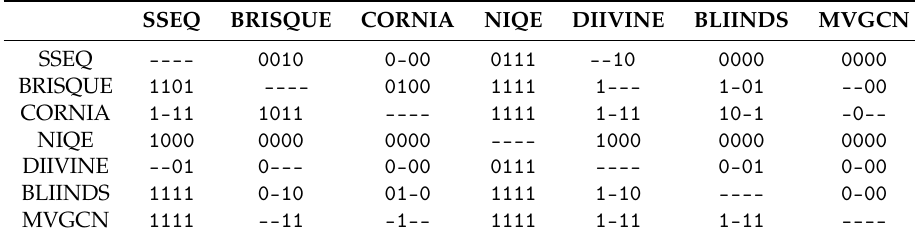
Table 5. Results of the statistical significance test performed between SROCC values of different NR IQA algorithms across four databases. The elements in each cell correspond to the following databases (from left to right): LIVE, CSIQ, TID08 and LIVE Challenge. ‘1’ means that the row algorithm is statistically superior to the column algorithm with a confidence of 95%; ‘0’ signifies statistically worse; and ‘-’ means statistical